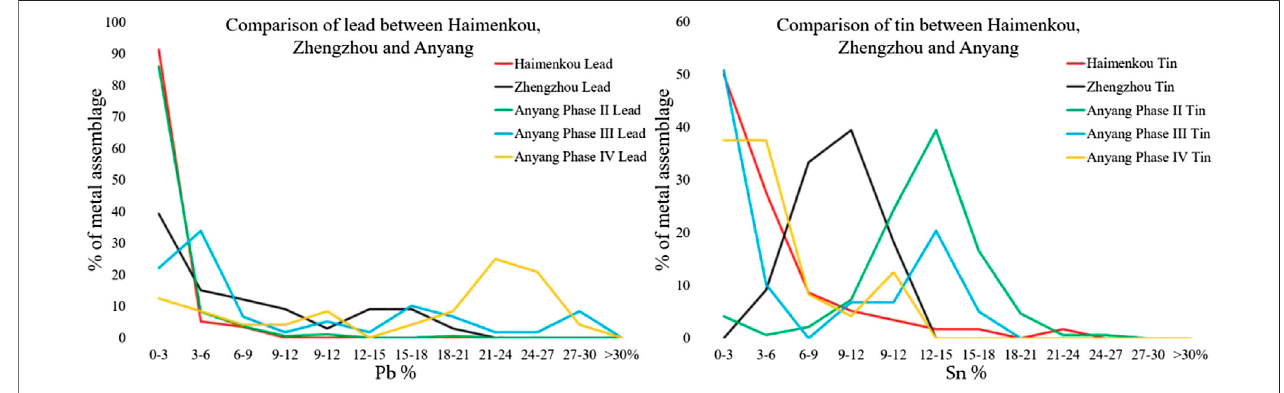
FIGURE 6 | Alloying pattern in Haimenkou, Zhengzhou and Anyang.